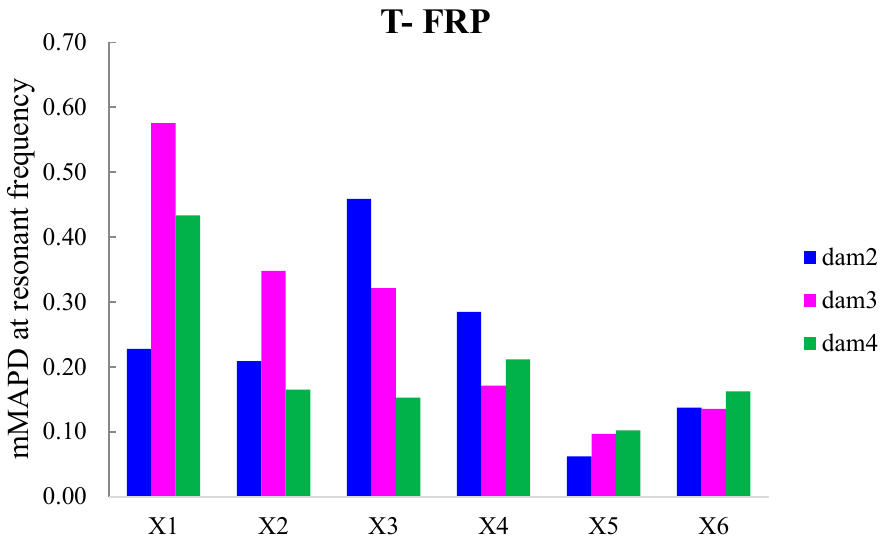
Figure 14. mMAPD at the resonant frequency of PTZs externally bonded on the surface of T-FRP.